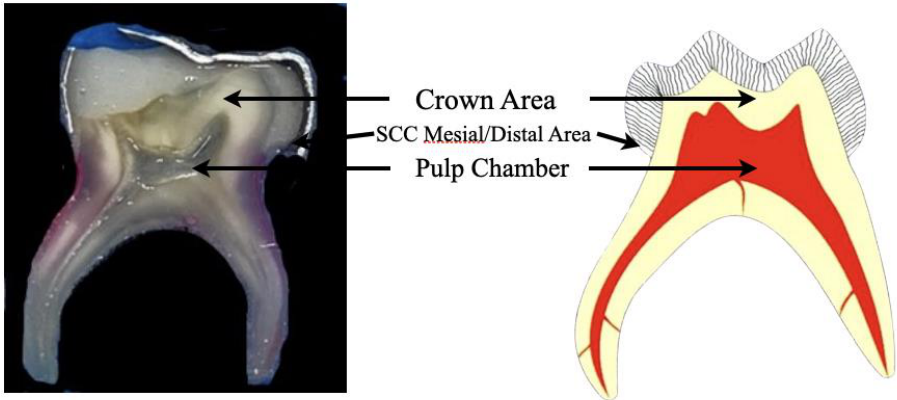
Figure 2. Preparation of teeth for confocal laser scanning microscopy. Mesiodistal coronal plane cuts were performed, and the teeth were stained with a LIVE/DEAD BacLight Bacterial Viability Kit.